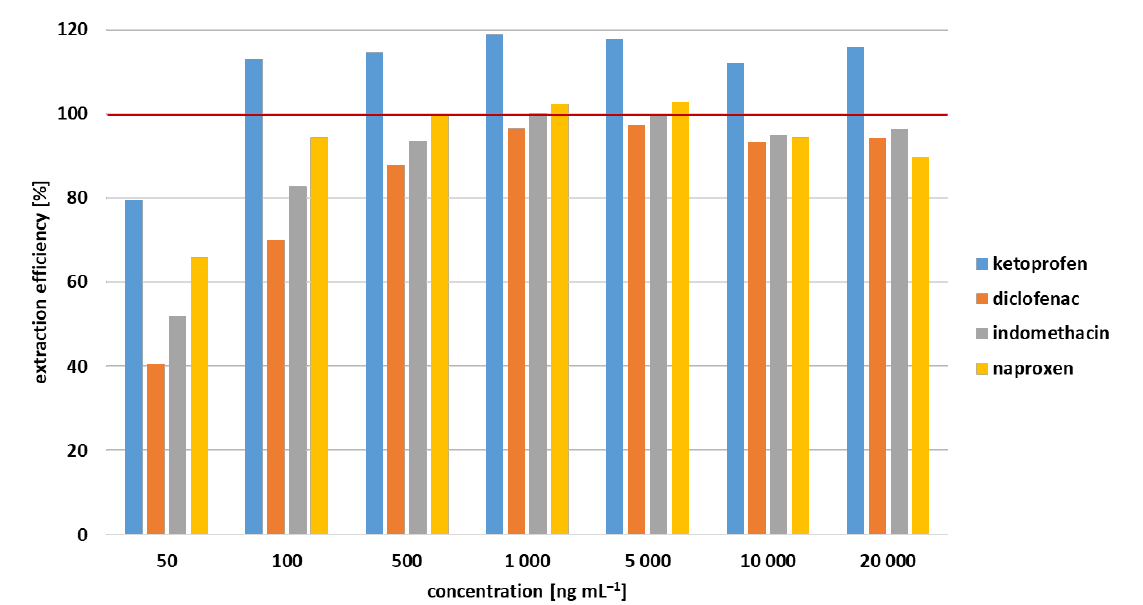
Figure 4. Extraction efficiency of micro/nano PCL sorbent expressed as a percentual recovery of NSAID in human serum.